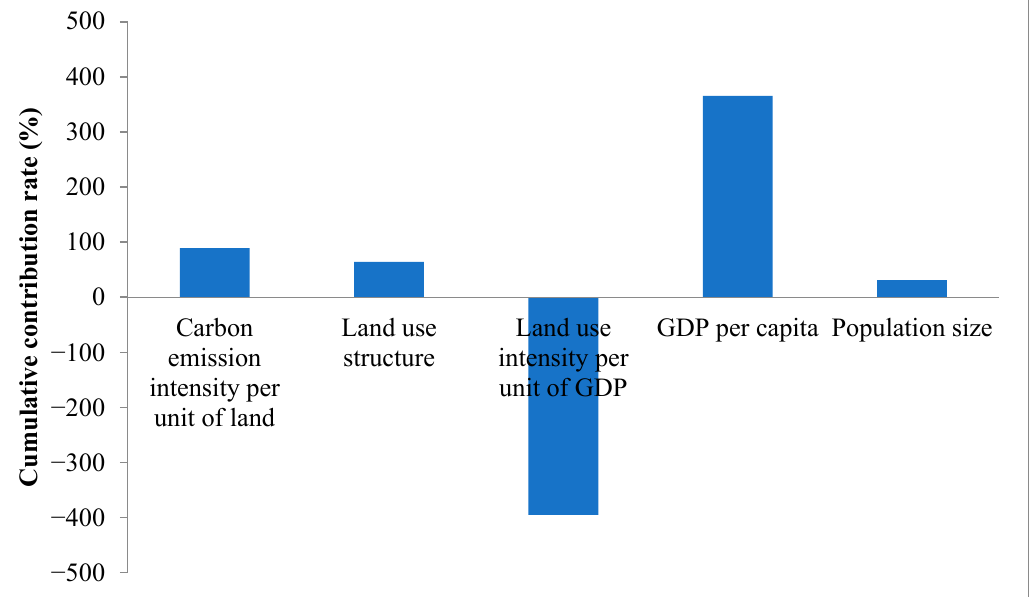
Figure 5. Cumulative contribution rate of influencing factors to the variation of carbon emissions from land use change in the Beijing-Tianjin-Hebei region.